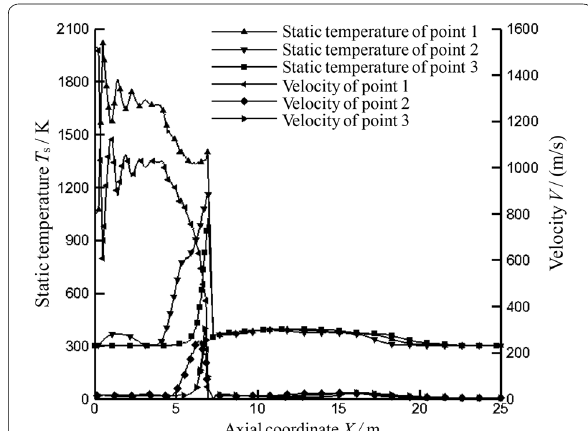
Figure 19 Static temperature and velocity curve of gas jet from twin engines